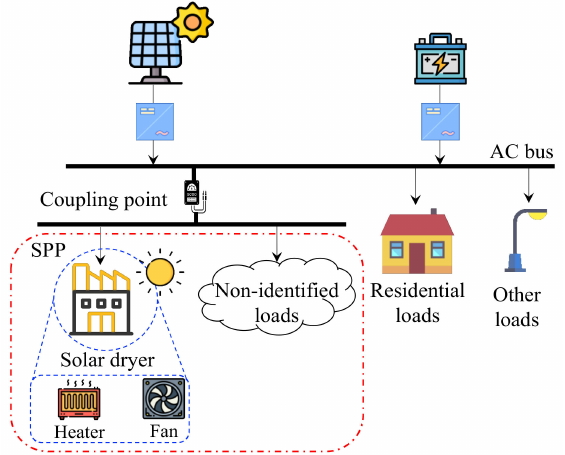
Figure 4. An overview of Caleta V í tor MG and